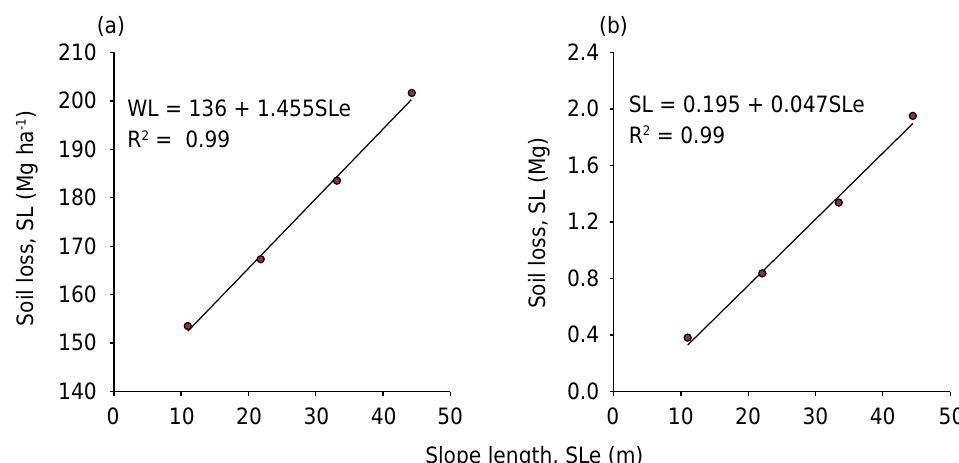
Figure 3. Relation between soil losses (SL), weight × area (a) and weight (b) and slope lengths (SLe) (total values per treatment)